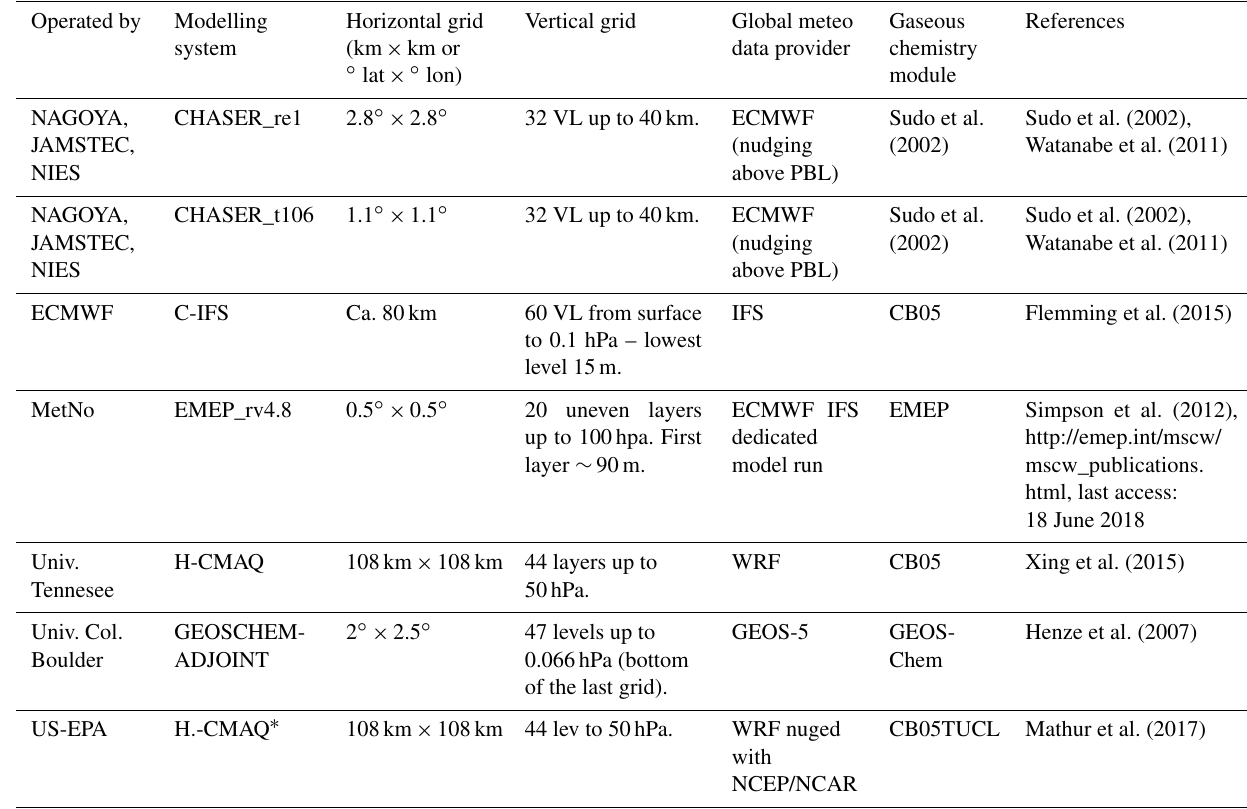
Table 2. Participating global modelling systems and key